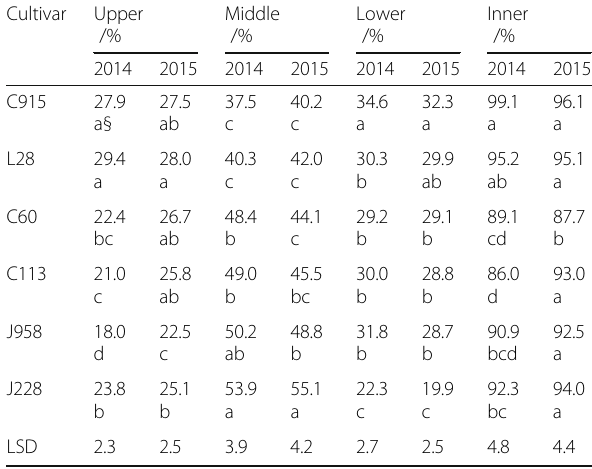
Table 2 Spatial yield distribution within the cotton canopies of different cultivars in 2014 and 2015 Cultivar